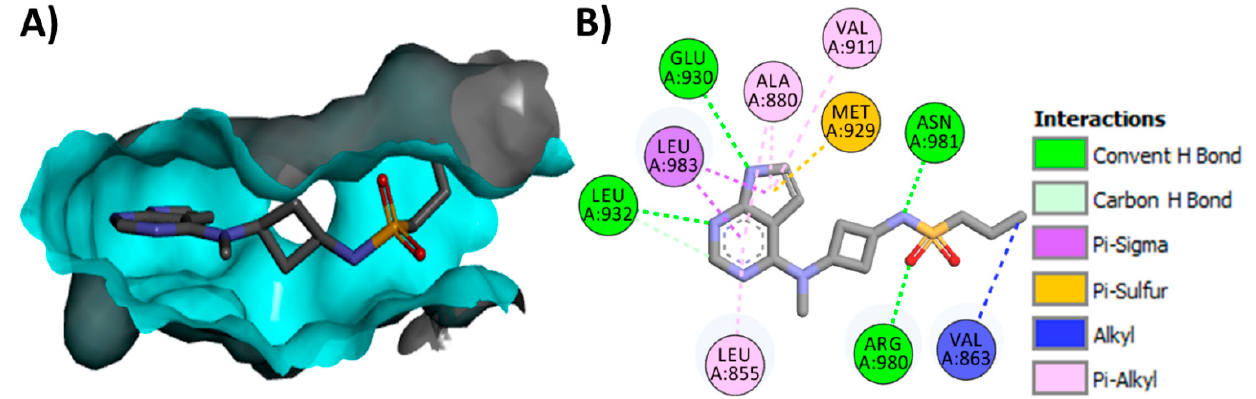
Figure 14. Binding modes of abrocitinib (shown as sticks) into JAK2 (pdb: 6BBV): ( A ) 3D binding mode, receptor shown as a hydrogen bond surface; ( B ) 2D binding mode showing different types of binding interactions with amino acids in JAK2; this figure was generated using Discovery Studio Visualizer (V16.1.0.15350).